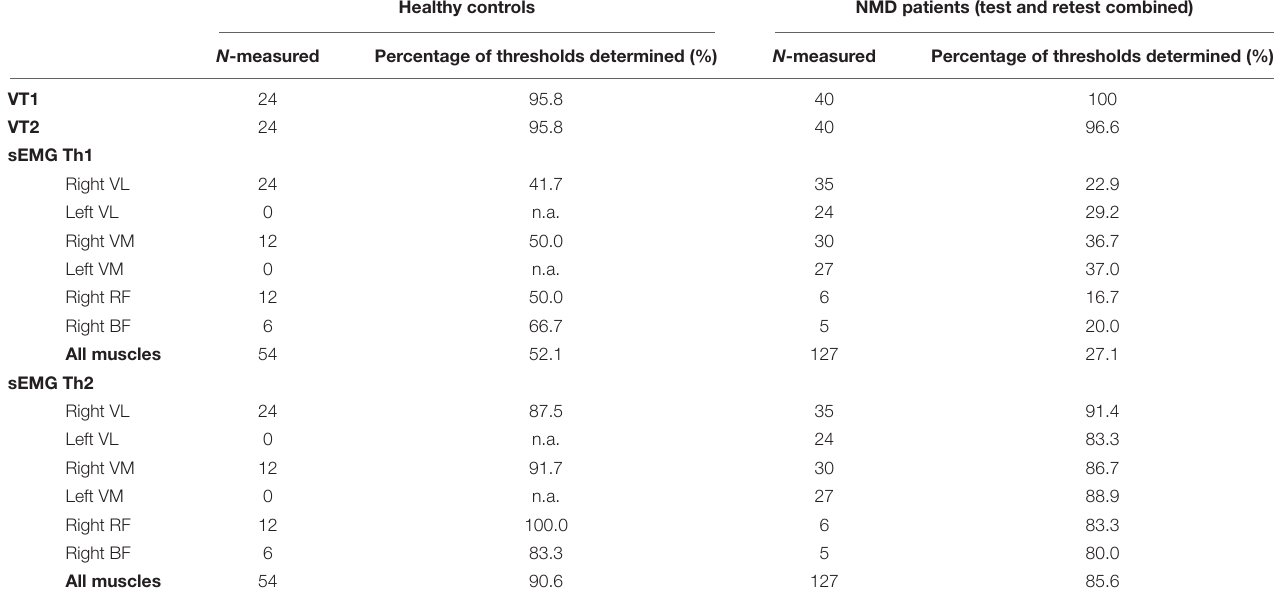
TABLE 3 | Inter-rater reliability for both sEMG thresholds for all muscles, healthy controls and patients combined.